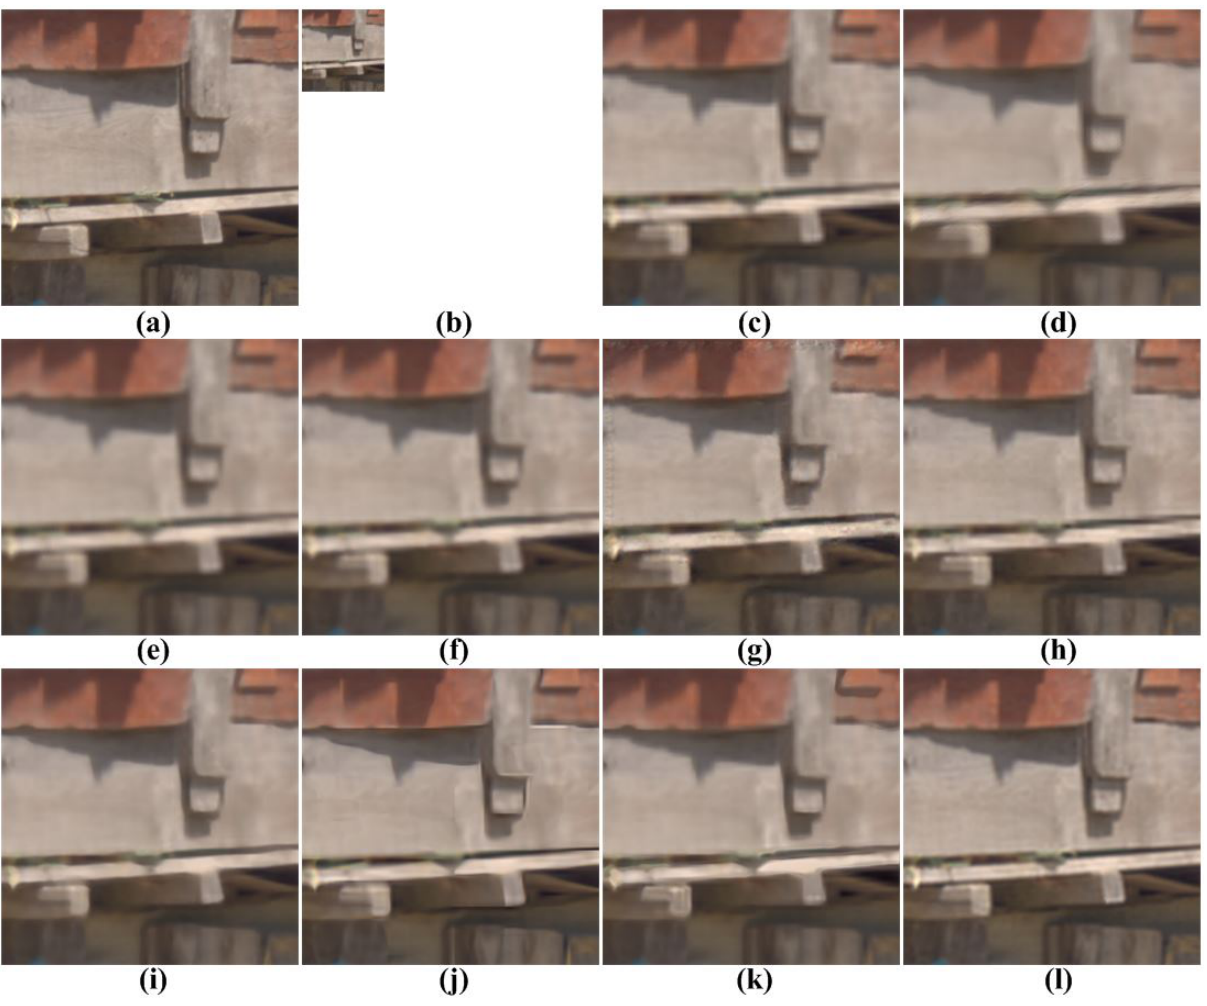
Figure 9. Results of resolution enhancement by enlarging a simulated LR multispectral image: ( a ) cropped original HR image in Figure 4e; ( b ) the four-times down-sampled LR image; results of: ( c ) cubic-spline interpolation [3], ( d ) interpolation-based SR [4], ( e ) interpolation-based SR [5], ( f ) interpolation-based SR [6], ( g ) example-based SR [7], ( h ) patch-based SR [9], ( i ) patch-based SR [10], ( j ) patch-based SR [11], ( k ) patch-based SR [12] and ( l ) the proposed